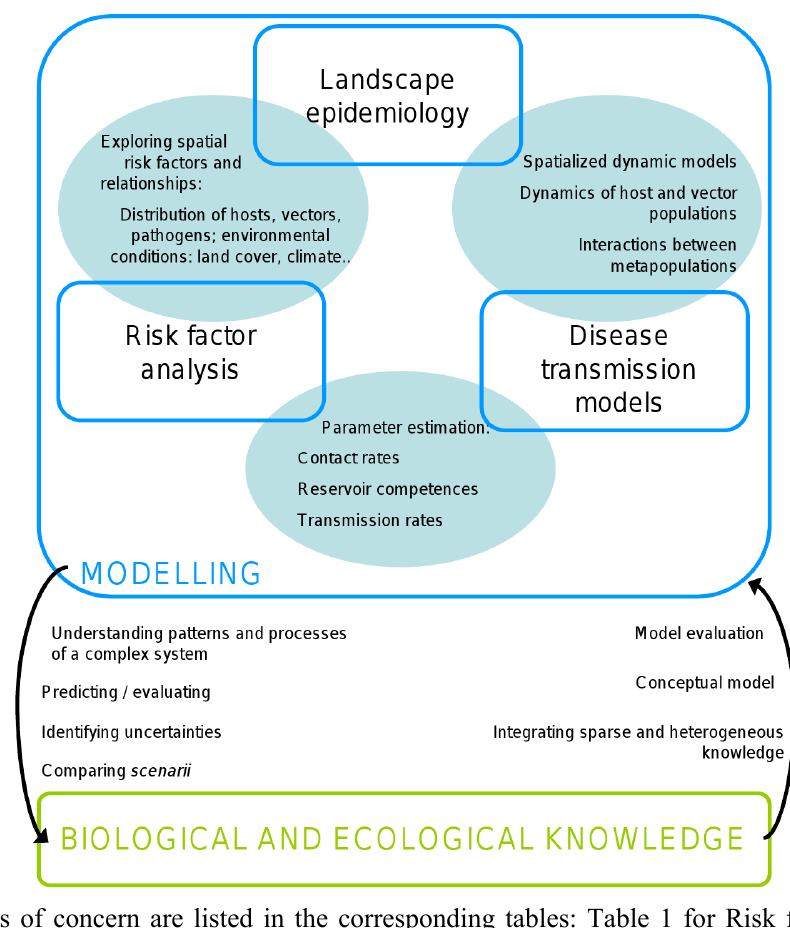
Table 2 for Landscape epidemiology and Table 3 for Disease transmission